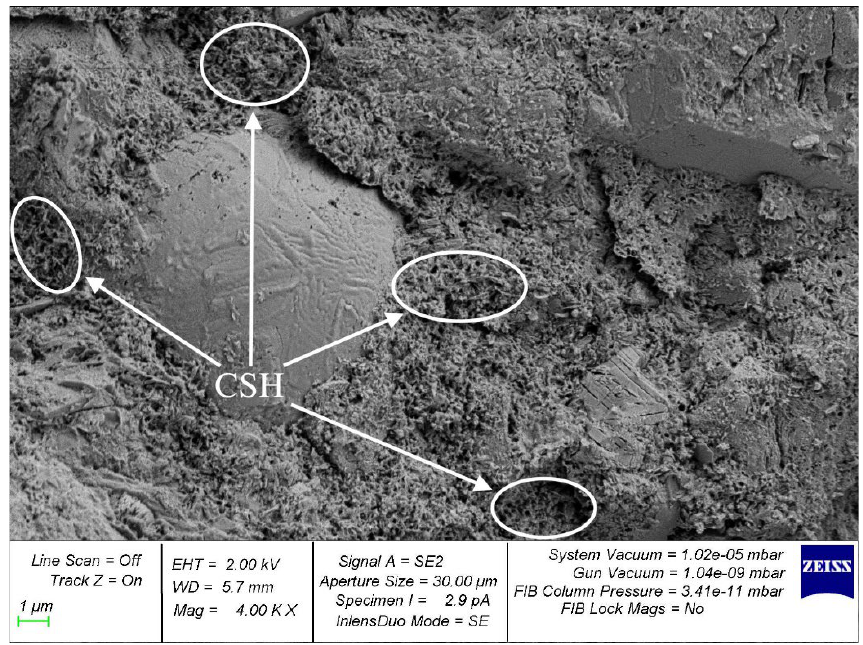
Figure 16. SEM image of the structure of an electromagnetically treated hardened cement paste with 5% RSA in place of part of the cement.